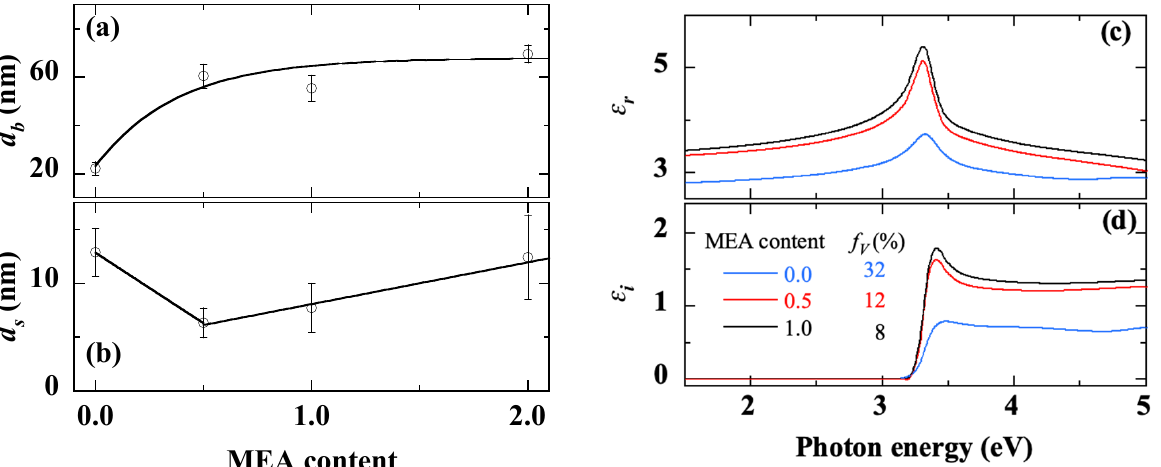
Figure 10. Thickness of the bulk layer ( a ) and the surface roughness ( b ), real ( c ) and imaginary ( d ) parts of the dielectric function extracted from SE measurements on sol-gel spin-coated ZnO samples obtained with various MEA contents. The curve and the lines in Figure 10a,b, respectively, are provided as guides for the eye.